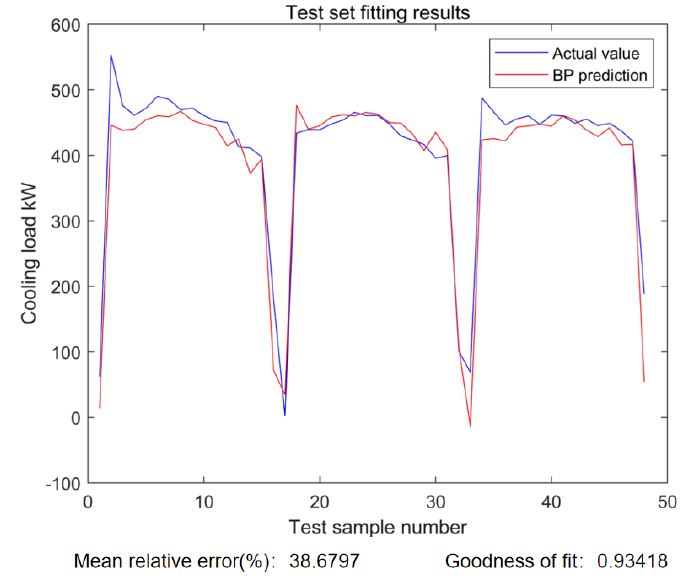
Figure 27. The fitting effect graph.